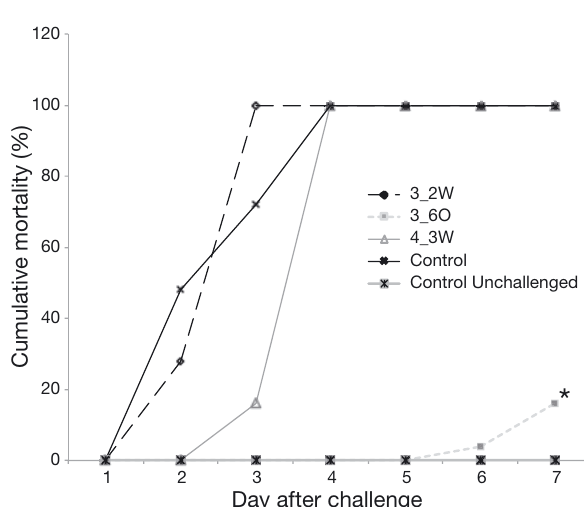
Fig. 3. Effect of surface-associated bacteria on the cumula- tive mortality of brown-marbled grouper fingerlings chal- lenged with pathogenic Vibrio harveyi . The fingerlings were treated with surface-associated bacteria ( Vibrio harveyi , iso- late 3_2W; Exiguobacterium acetylicum , isolate 3_6O; or Psychrobacter sp. isolate 4_3W) or marine broth (control) for 12 d before the challenge (n = 25 for each group). One con- trol group not challenged served as negative control. A star indicates the bacterial cultures that significantly (p < 0.05) reduced